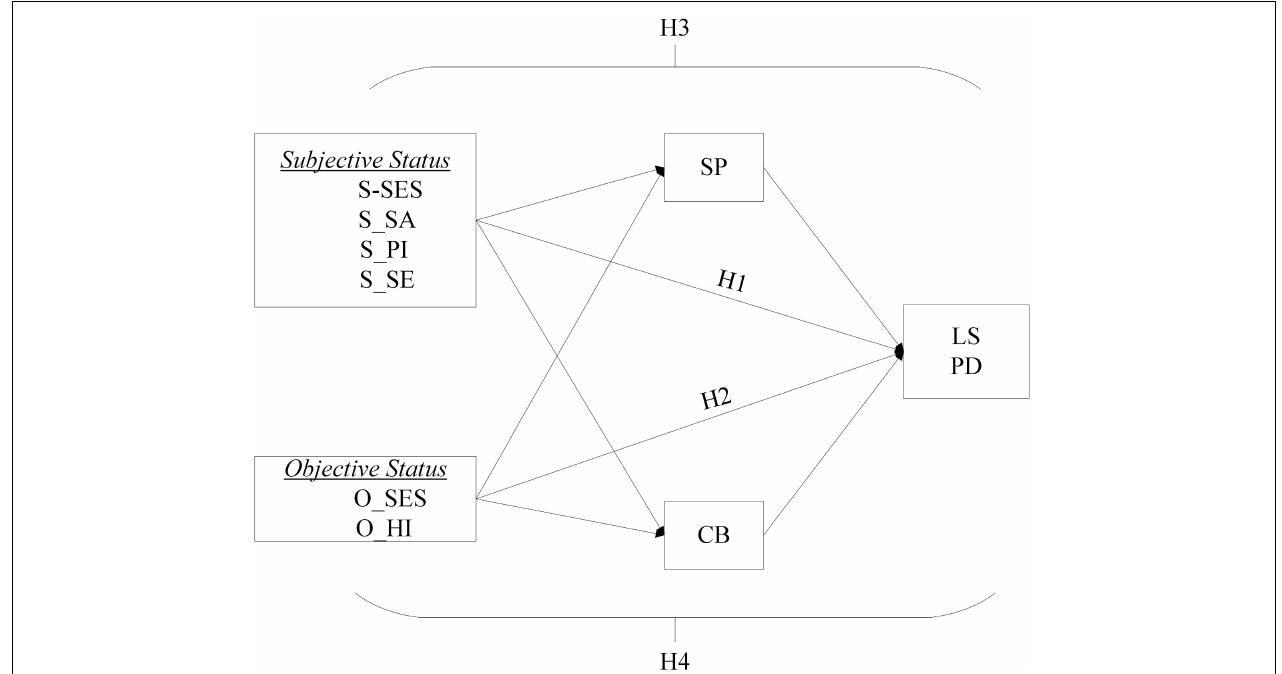
FIGURE 1 | The Hypothesized Path Analysis Model of Life Satisfaction and Psychological Distress in the Sample of Young Internal Migrants. HI to H4 are displayed in the last paragraph of the introduction part. S_SES, Subjective Socioeconomic Status; S_SA, Social Adaptation; S_PL Psychological Integration; S_SE, Social Exclusion; 0_SES, Objective Socioeconomic Status; 0_HI, Health Insurance; SP, Social Participation; CB, City Belonging; LS, Life Satisfaction; PD, Psychological Distress.